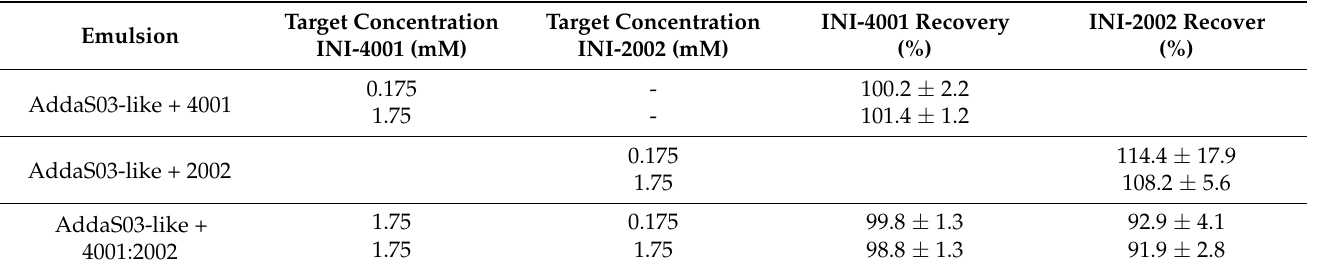
Table 1. TLR agonist recovery after sterile filtration of emulsions. INI-4001 and INI-2002 were incorporated into AddaS03-like emulsions singly or in combination at given target concentrations. Percentage recovery was calculated by comparing the agonist concentration pre- and post-filtration with a 0.22 µ m filter. Results are presented as mean ± SEM for replicate emulsions ( n =